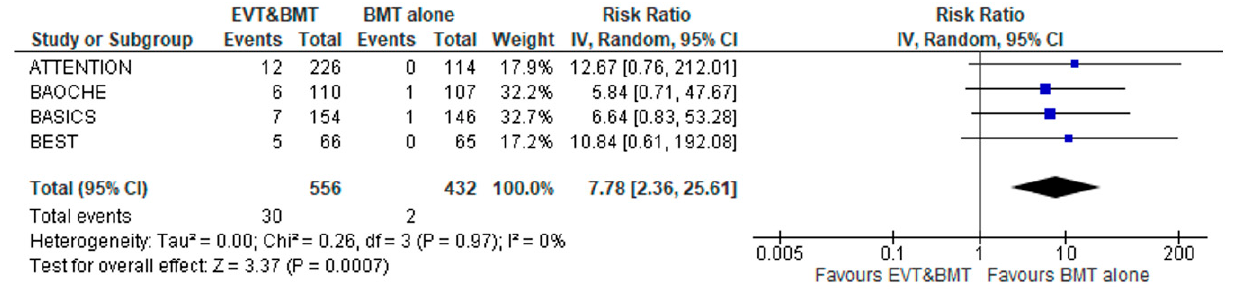
Figure 3. Forest plot presenting the association of endovascular treatment (EVT) combined with best medical treatment (BMT) compared to BMT alone with symptomatic intracranial hemorrhage (sICH) among acute basilar artery occlusion patients.